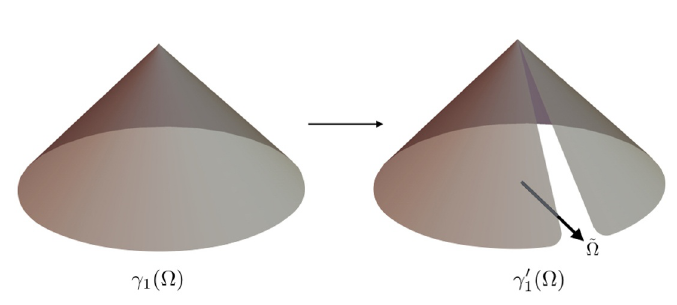
Figure 4 . Pinching γ 1 to γ 0 gives a null surface with vanishing space-time 1